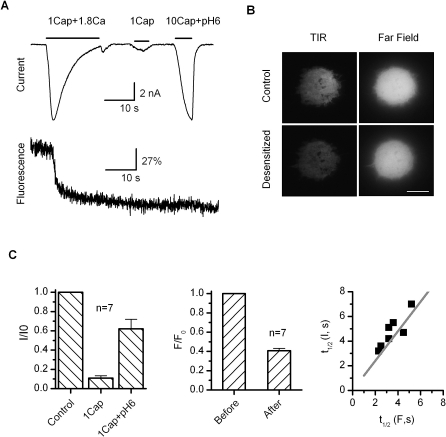
Correlation of Desensitization and Depletion of PIP2(A) Simultaneous patch-clamp and TIRF recording from live cells transiently transfected with TRPV1 and mRFP-tagged PLC-δ PH domain. Desensitization by 1 μM capsaicin and 1.8 mM Ca2+ resulted in a rapid, concomitant decay in the mRFP fluorescence intensity. Subsequent to the desensitization, 1 μM capsaicin and 10 μM capsaicin plus pH 6 were applied respectively to ensure full desensitization of the current and the remaining of the channels on the cell surface. In the absence of Ca2+, capsaicin itself caused no detectable change in the mRFP fluorescence.(B) Fluorescent images of cells before (top) and after (bottom) desensitization. Left, near-field; right, wide-field. Scale bar: 10 μm.(C) Statistical measurements of the current and fluorescence and their half-decay times plotted against each other for each cell. The fluorescence decay reached ∼59% following desensitization, and had an average half-decay time constant t
1/2 = 3.5 ± 0.6 s, which was comparable to that of the current (5.4 ± 0.8 s).